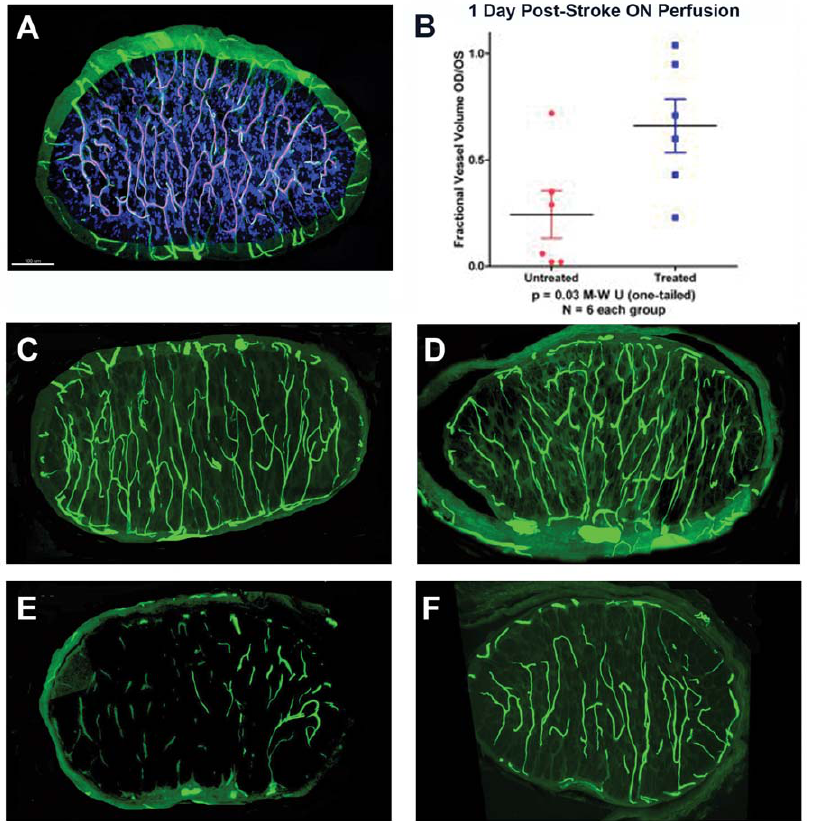
Figure 2. Microvascular analysis of naı¨ve and infarcted ONs at 4 hours and 1 day post-induction. A. FITC-BSA vascular imaging of naı¨ve ON. Filled capillaries are relatively uniformly distributed throughout the nerve, communicating with peripheral vasculature. B. Quantitative capillary analysis of 1 day post-rAION-induced ON, in vehicle- and PGJ 2 -treated animals. Infarcted nerves were compared with the contralateral (naı¨ve control) nerve of the same animal (1.0 of filling), and expressed on the Y axis as a fractional vessel volume (OD/OS). PGJ 2 -treated animals show significantly more patent capillaries at one day than vehicle treated animals (Mann-Whitney U test, p , 0.03). C and D: ON capillary filling 4 hours post-induction. There is minimal loss of capillary patency in both vehicle- (panel C) and PGJ 2 -treated (panel D) nerves. E and F: ON capillary filling 1 day post- induction. There is significant loss of vascular patency in ONs of vehicle treated animals (panel E). ONs in PGJ 2 -treated animals (panel F) reveal considerably more patent vasculature at one day. Scale bar: 100 microns.